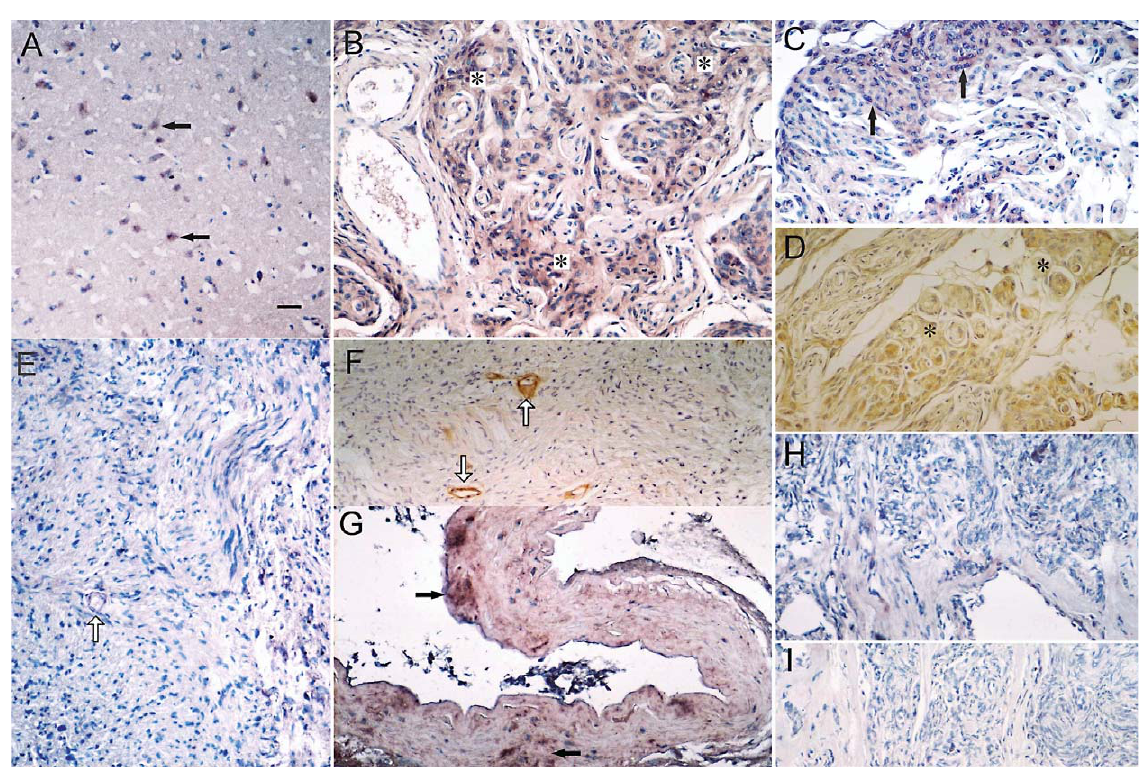
Fig. 5. By in situ hybridization, the staining intensity and expression pattern of WWOX mRNA resembles that of immunoreactivity. In normal brain tissue, low to moderate expression for WWOX mRNA was present in some cortical neurons (a). WWOX mRNA appeared high in the small whorls of malignant meningioma (b, c), resembling its protein expression by immunohistochemistry (d). Low levels of WWOX mRNA expression were observed in tumor cells of transitional meningiomas (e). Note that some small capillaries (arrows in e & f) were positive for WWOX mRNAs and proteins (f). Interestingly, WWOX mRNA was also expressed moderately in some large blood vessels (g). Similar patterns for WWOX mRNA were also found in another transitional meningiomas (h). Negative control is shown in (i). Bar=50 (cid:1)